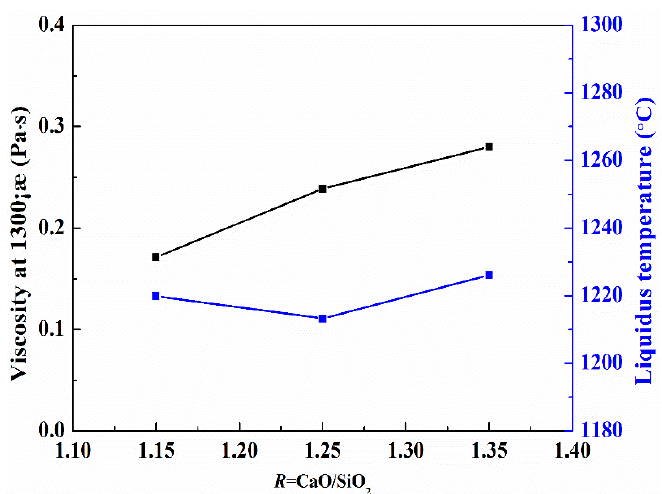
Figure 5. E ff ect of basicity on viscosity of fluoride-free mold flux 1300 ◦ C. Figure 5. Effect of basicity on viscosity of fluoride-free mold flux 1300 °C.